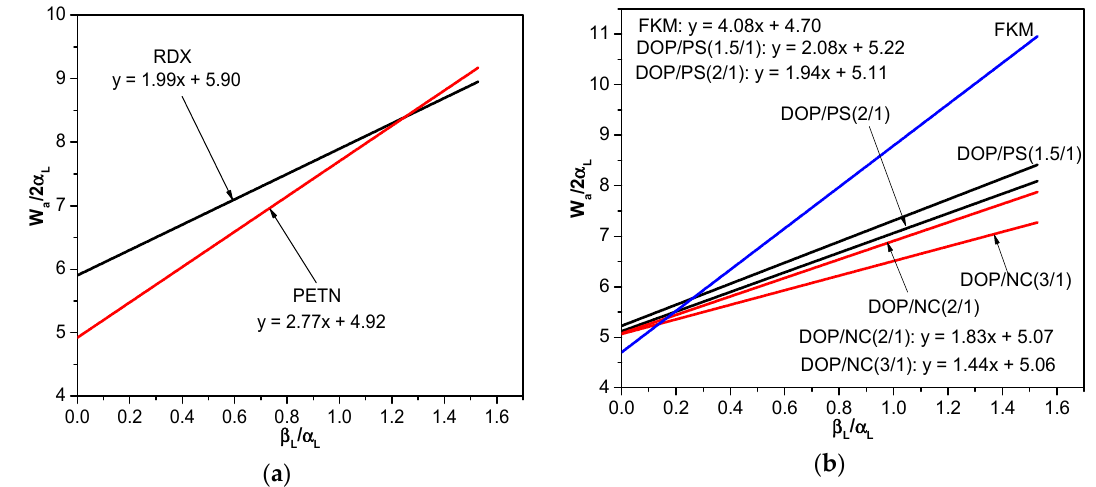
Figure 3. The (W a /2 α L ) versus ( β L / α L ) plot of ( a ) energetic materials and ( b ) several binders.